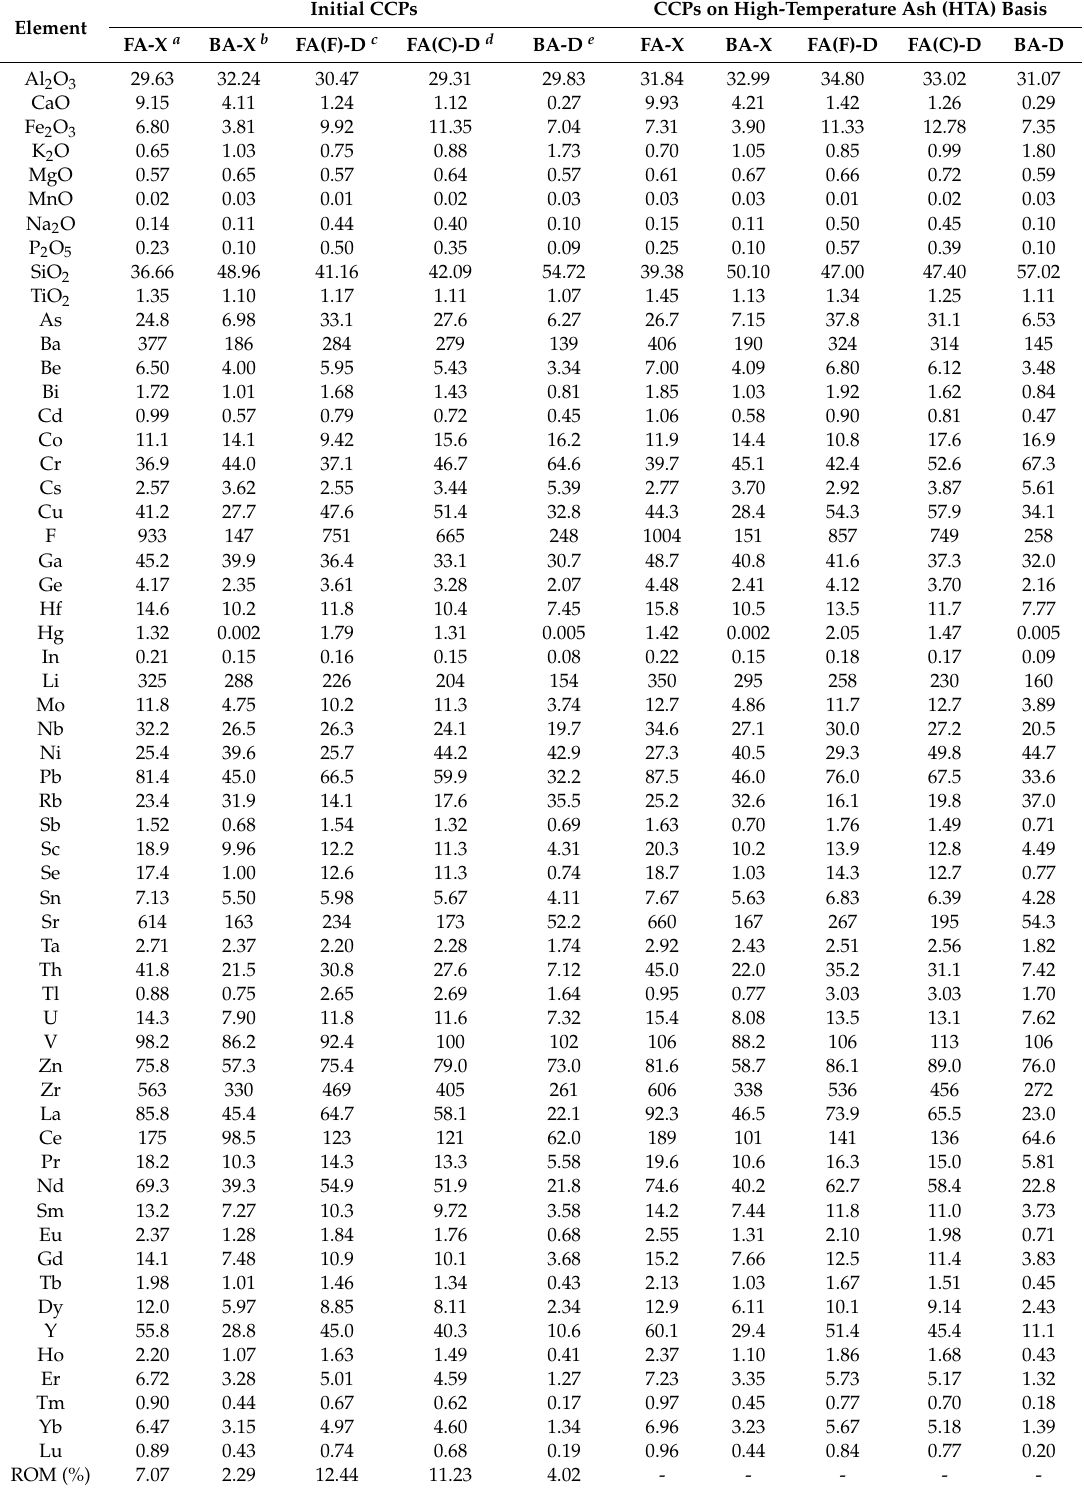
Table 5. Average concentrations of major (%) and trace ( µ g / g) elements in the coal combustion products (CCPs) from the Xilaifeng and Damo power plants.